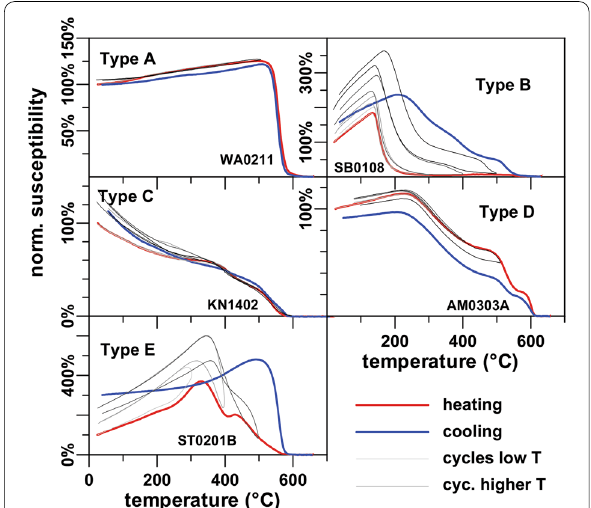
Fig. 2 Representative examples of five types of bulk susceptibility thermomagnetic curves. Heating is shown in red, cooling in blue, and thermal cycling in